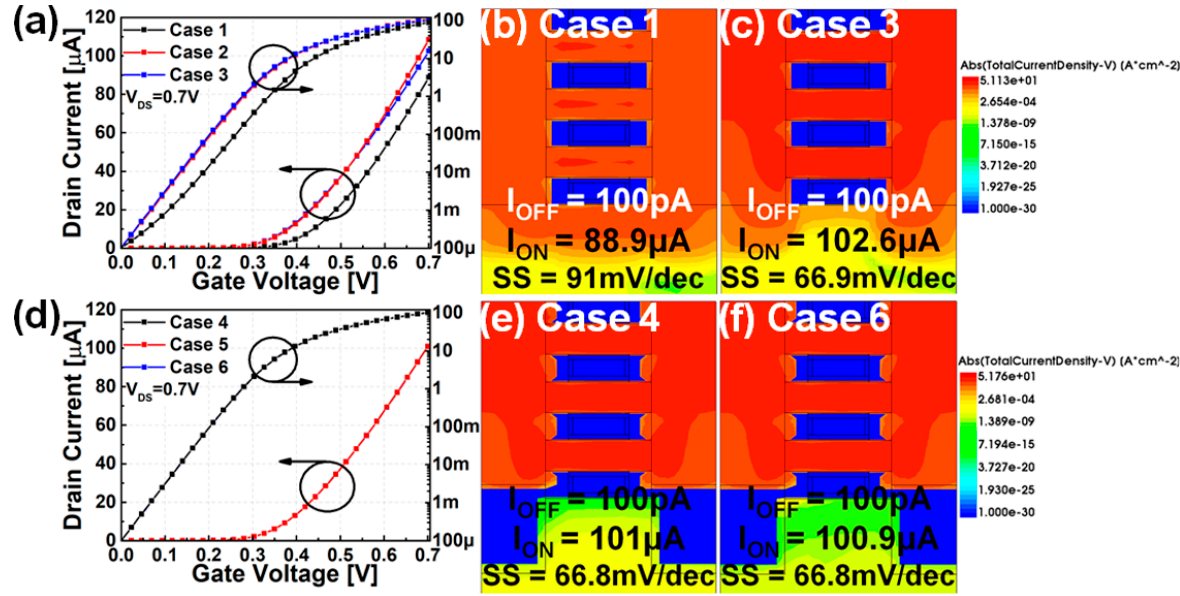
Figure 3. ( a ) I DS versus V GS characteristics for cases 1–3, Current density profile for ( b ) Case 1, ( c ) Case 3, ( d ) I DS versus V GS characteristics for cases 4–6, Current density profile for ( e ) Case 4, ( f ) Case 6.